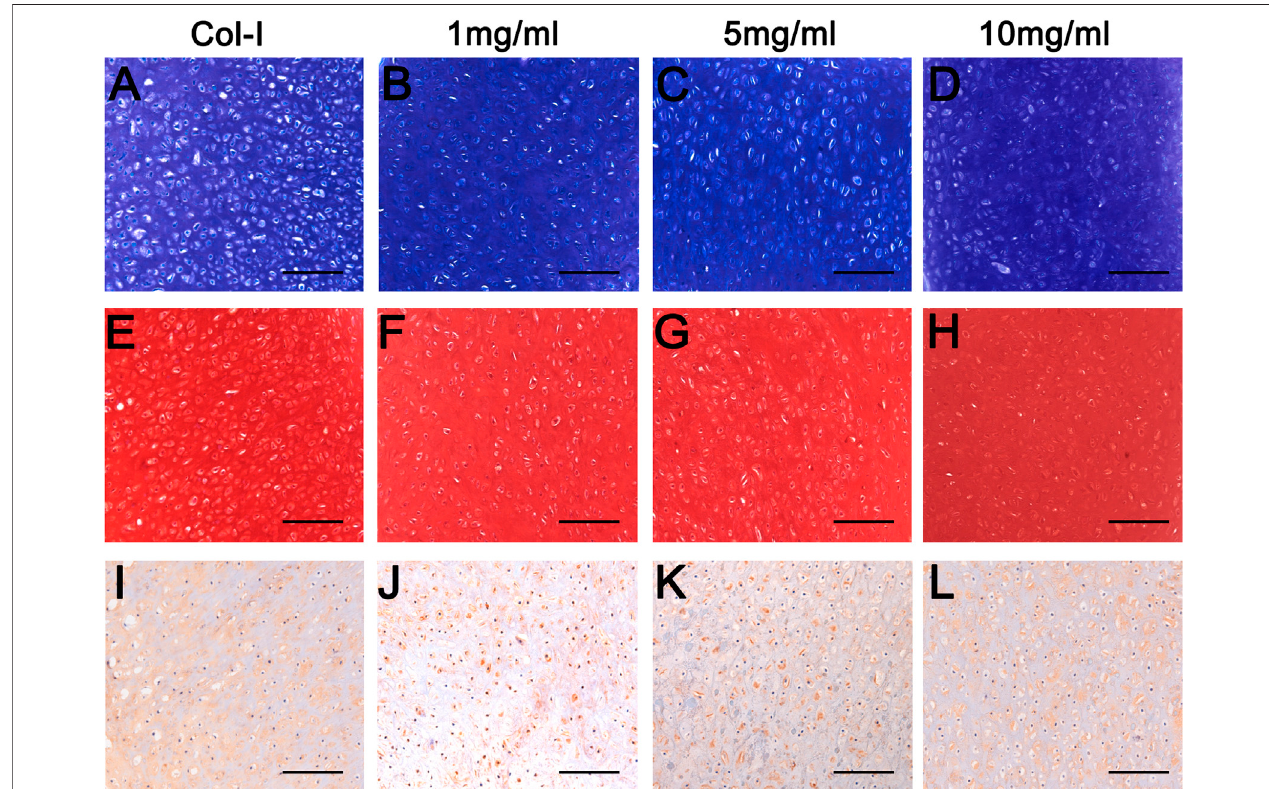
FIGURE 8 | Histological analyses of grafts from dcECM hydrogels at 8 weeks after transplantation. Grafts were harvested and further analyzed at 8 weeks after grafting. (A – D) Toluidine-bluestainingoftheCol-I (A) ,1 (B) ,5 (C) ,and10 (D) mg/mldcECMhydrogelgrafts. (E – H) SafraninOstainingofgraftsfromCol-I (E) ,1 (F) ,5 (G) and 10 (H) mg/ml dcECM hydrogels. (I – L) Collagen II expression of Col-I (I) , 1 (J) , 5 (K) , and 10 (L) mg/ml dcECM hydrogel grafts were compared via histological staining. Scale bars (cid:2) 100 μ